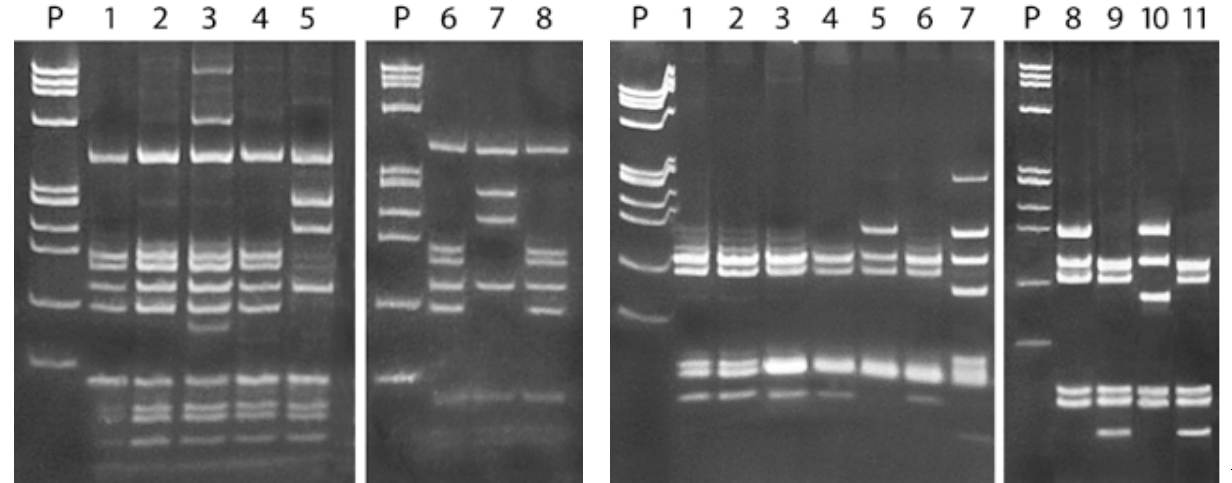
A Figure 4. Results of RFLP analyses with Tru1 I on R16(I)F1/R1 amplicons (1,100 bp) ( A ) and on M1/M2 amplicons (500 bp) ( B ) obtained from phytoplasma colonies. Samples in ( A ) 1, colony from strain CH-1 and 2, colony from strain STOL from Mycoplasma Experience laboratory (MEX); 3, colony from strain CH-1 and 4, colony from strain STOL from University of Bologna laboratory (UB); 5, colony from strain CY-TO at MEX; 6, strain CH-1 from micropropagated periwinkle; 7, strain CY-TO from micropropagated periwinkle; 8, strain STOL from micropropagated periwinkle. Samples in ( B ) 1, colony from strain CH-1 and 2, colony from strain STOL from MEX; 3, colony from strain CH-1 and 4, colony from strain STOL from UB; 5, colony from strain CY-TO and 6, colony from strain CH-1 at MEX (isolated from shoot in water, table 2); 7, colony from strain PD at UB; 8, strain CY-TO from micropropagated periwinkle; 9, strain CH-1 from micropropagated periwinkle; 10, strain PD from micropropagated periwinkle; 11, strain STOL from micropropagated periwinkle; P, marker Ф X174 Hae III digested, fragment sizes (from top to bottom): 1,353; 1,078; 872; 603; 310; 281; 271; 234; 194; 118, and 72.